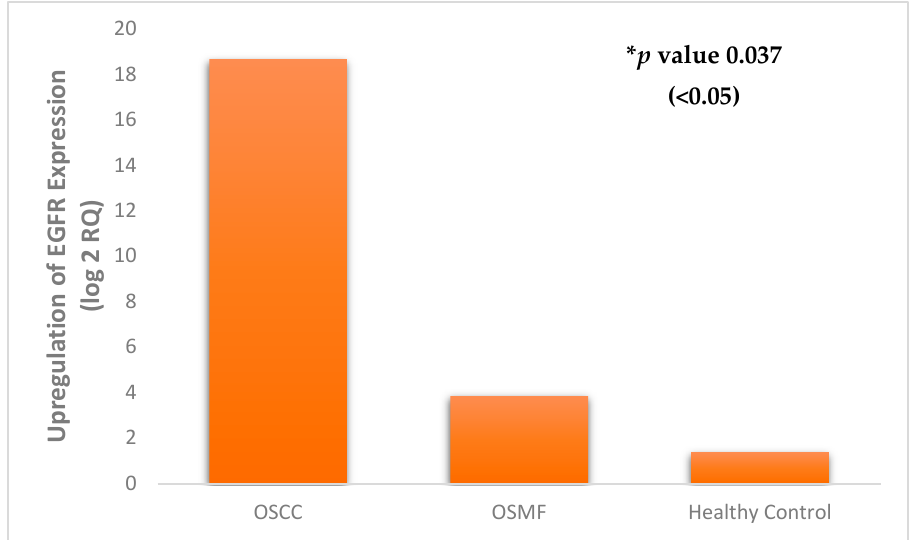
Figure 7. Differential expression of EGFR in healthy controls vs. OSMF vs. OSCC. * Statistical analysis performed using Student’s t -test.